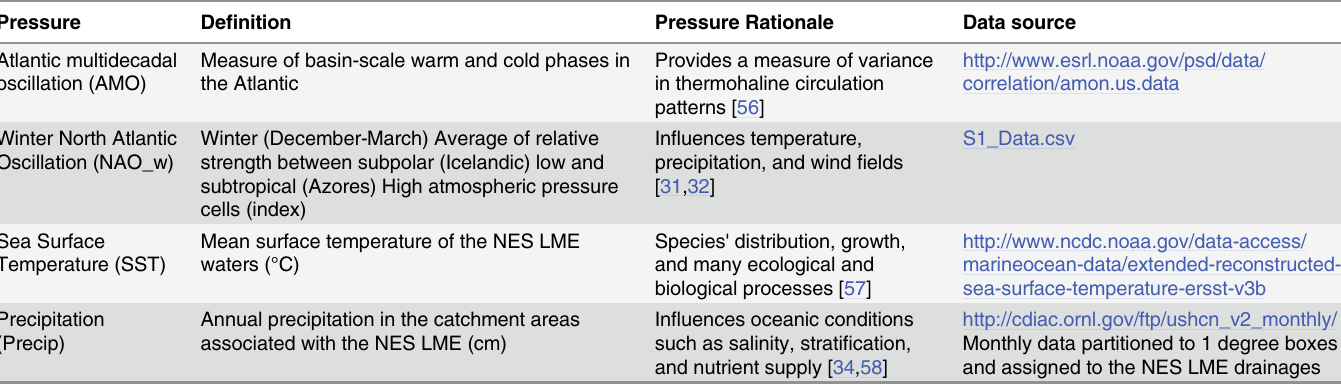
Table 2. Environmental factors used as pressure variables in gradient forest